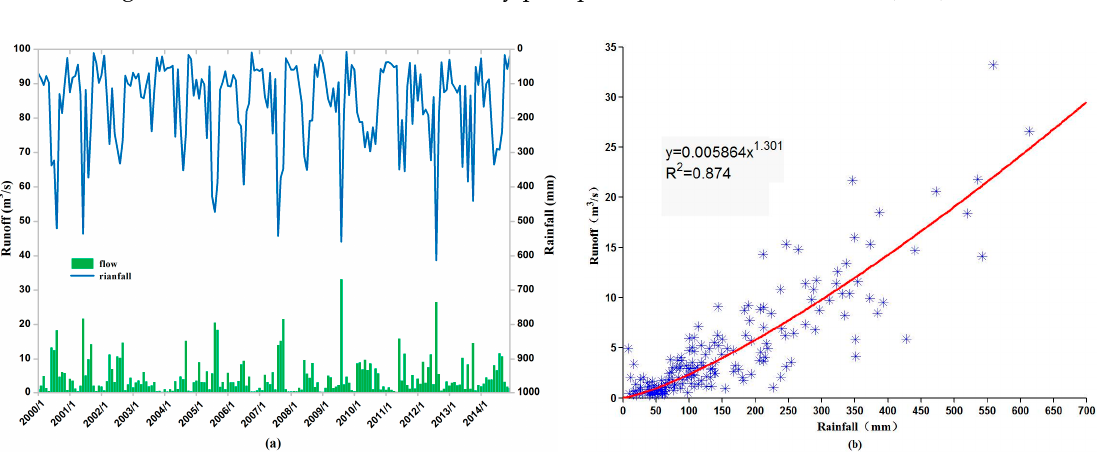
Figure 3. The correlation between rainfall and runoff: ( a ) Monthly change of rainfall and runoff during the last fifteen years; ( b ) Fitted equation of precipitation and runoff y = 0.005864 x 1.301 , R 2 = 0.874.